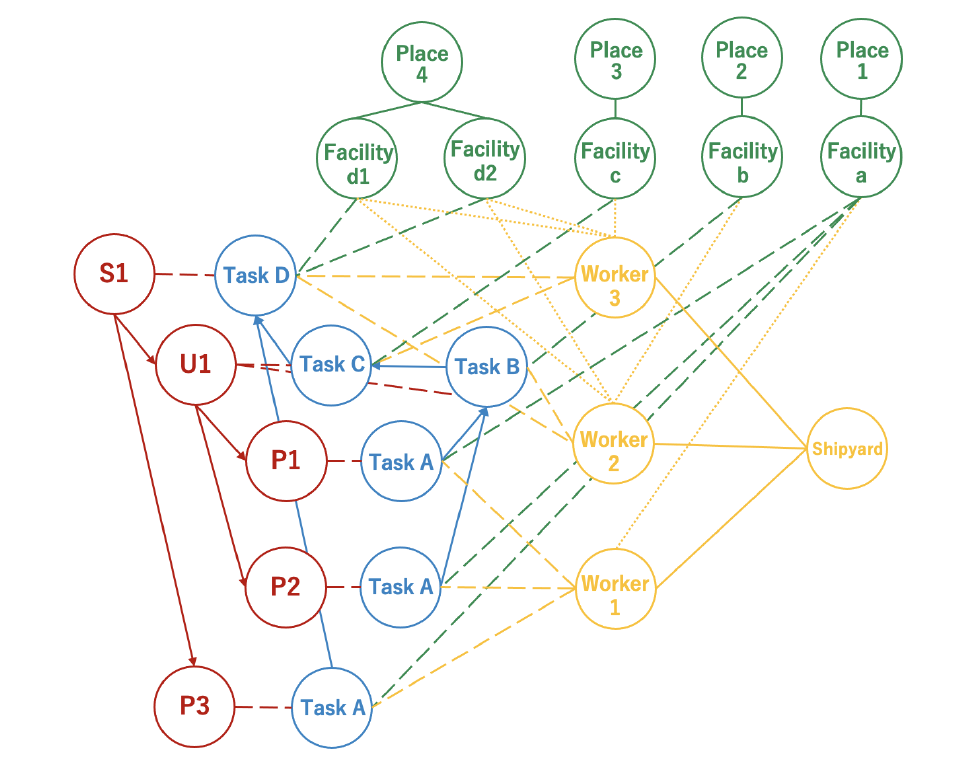
Figure 6. Simulation Model of The Target Shipbuilding